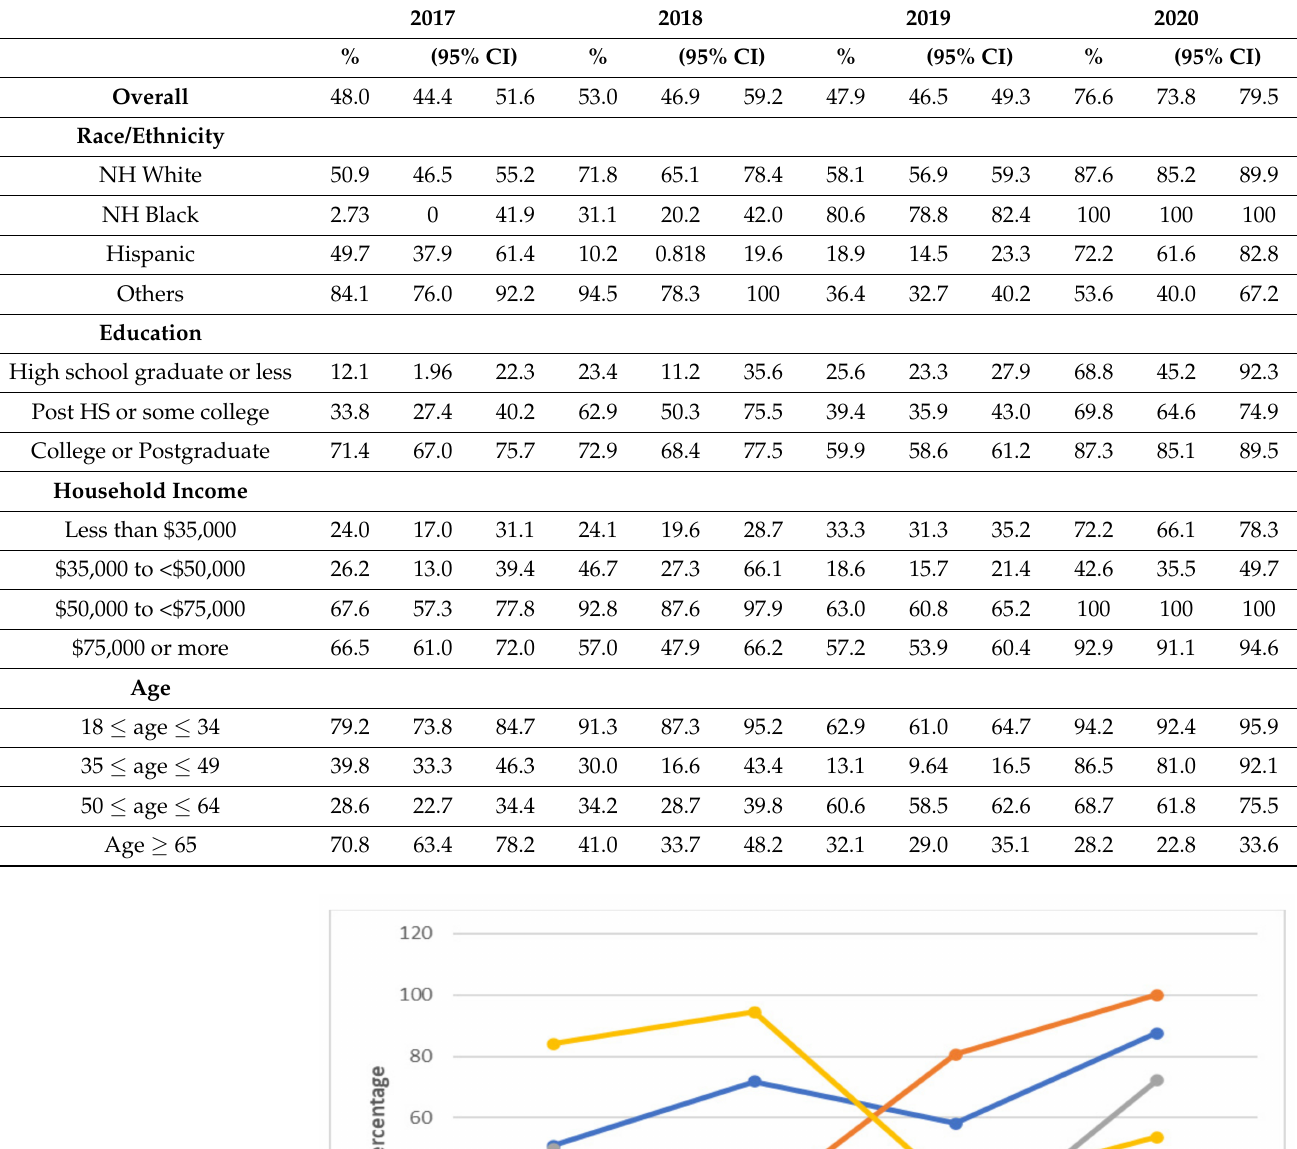
Table 2. Awareness of the HPV vaccine among gay and bisexual males in the US.